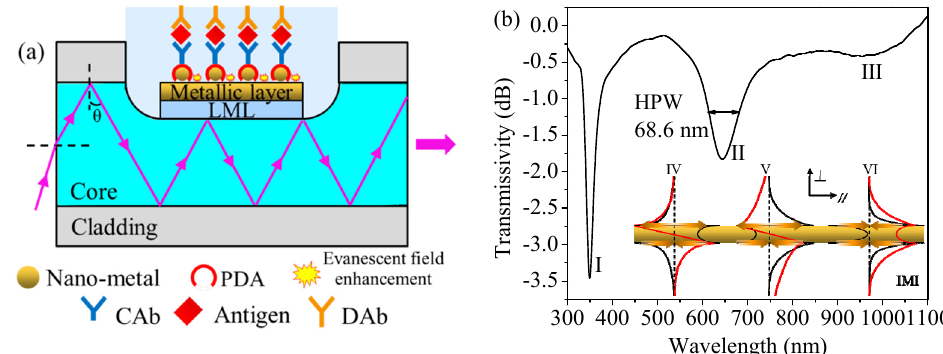
Figure 1. ( a ) Diagram of the LR − SPR biosensor based on synergistic improvement of sandwich immunoassay and plasmonic coupling. ( b ) Transmission spectrum of the LR − SPR sensor (I: characteristic absorption line, II: long − range resonance curve, III: short − range resonance curve). Inset: the field/current distributions of three modes with the lowest loss in the insulator − metal − insulator (IMI) model (IV–VI: three modes, red line: electric field distribution, black line: magnetic field distribution, orange arrow: current conduction). Reproduced with permission from reference [21] by John Wiley and Sons.